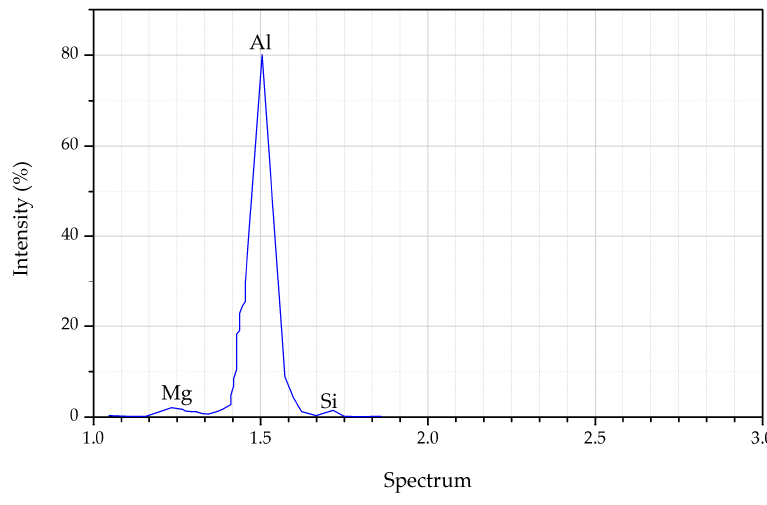
Figure 1. EDS spectra for AA6061.